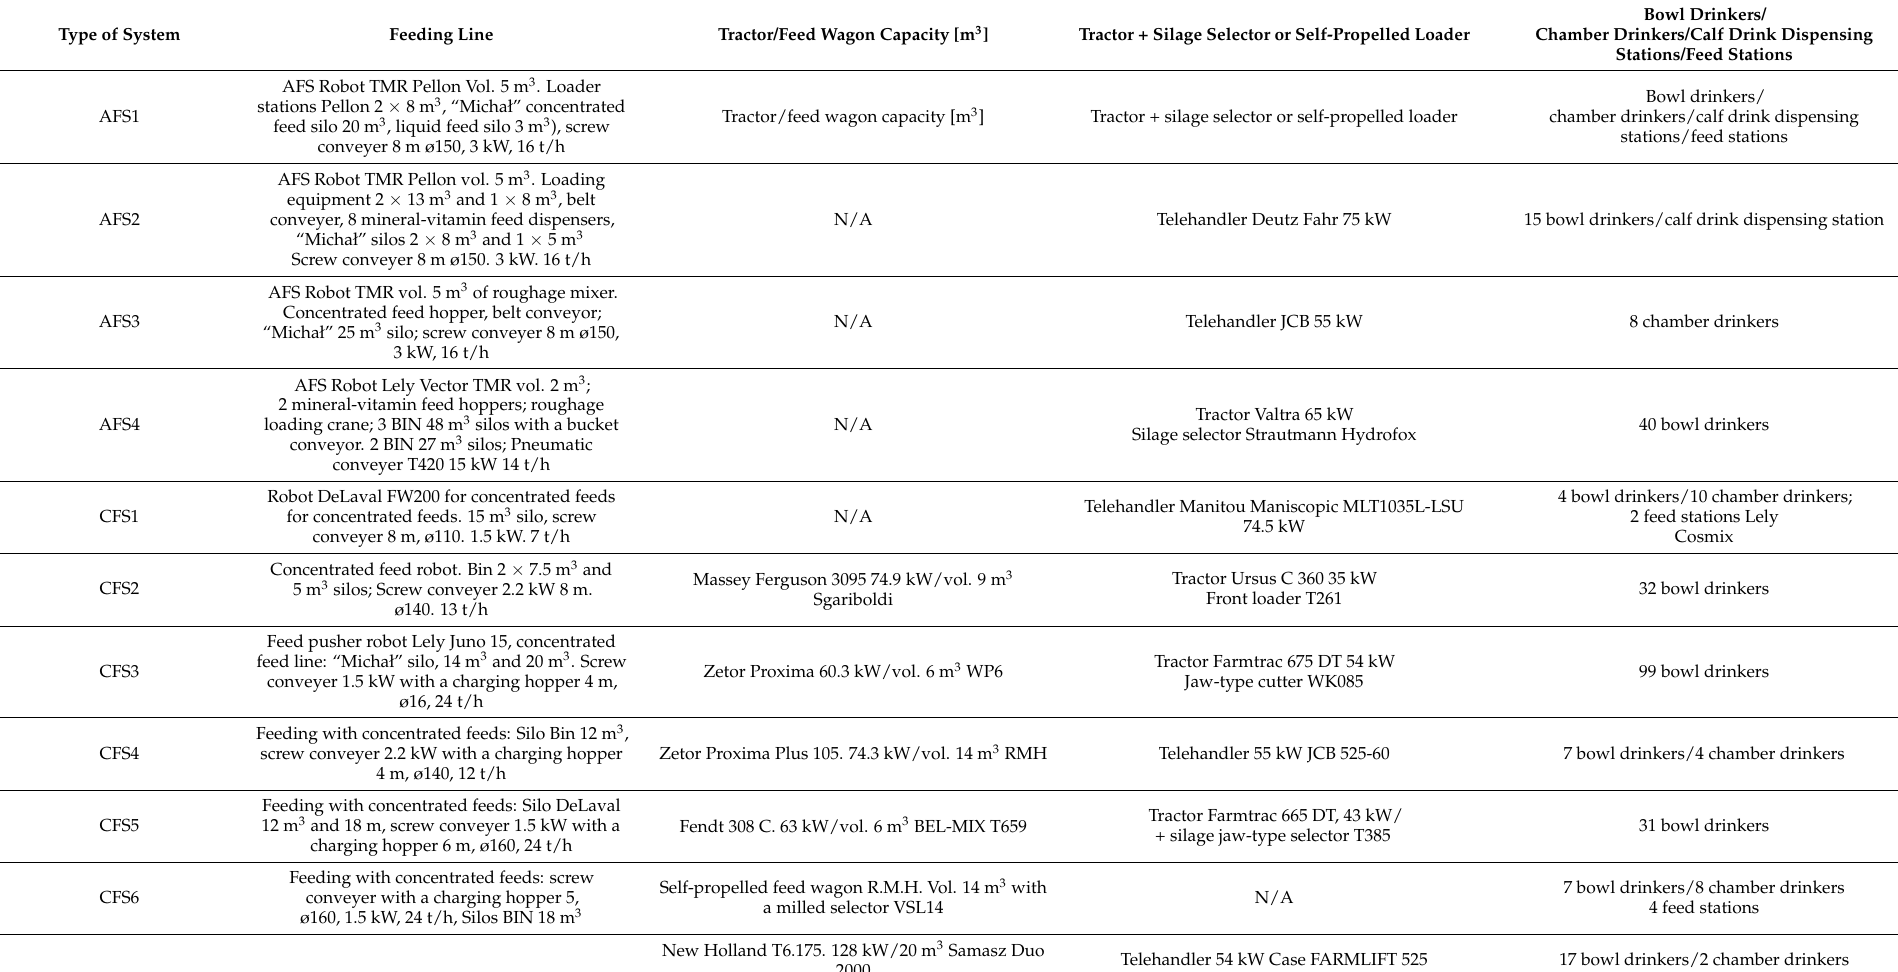
Table 6. Breakdown of feeding machinery and equipment for mechanization and automation in